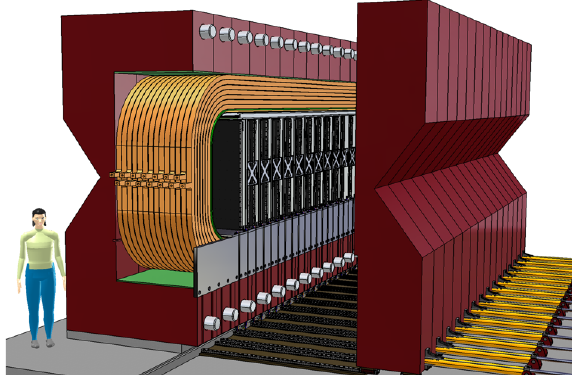
Figure 3. The magnet hosting the scattering and neutrino detec- tor.